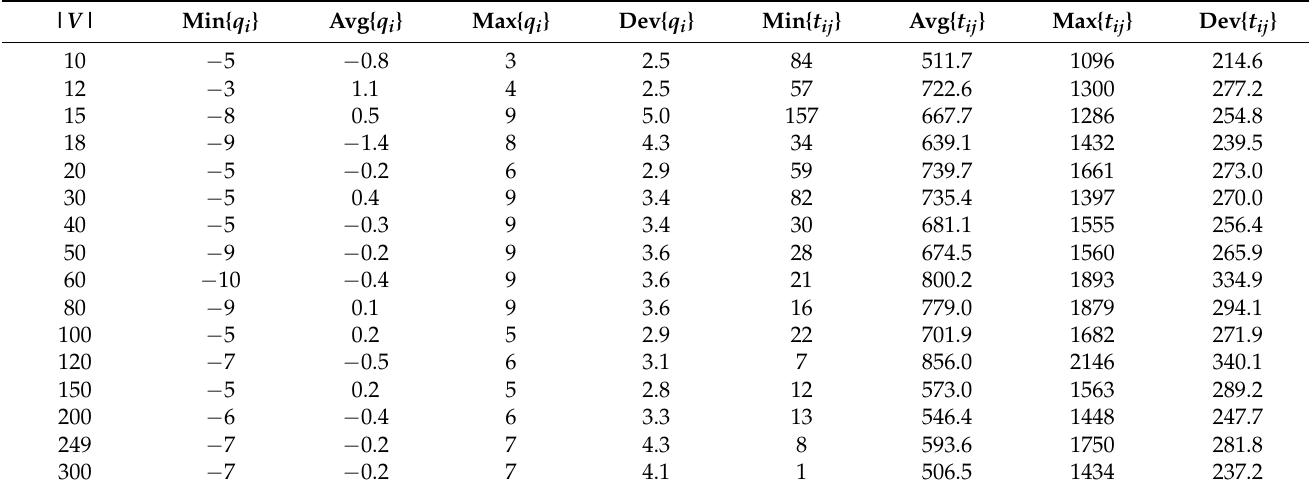
Table 2. Some characteristics of random